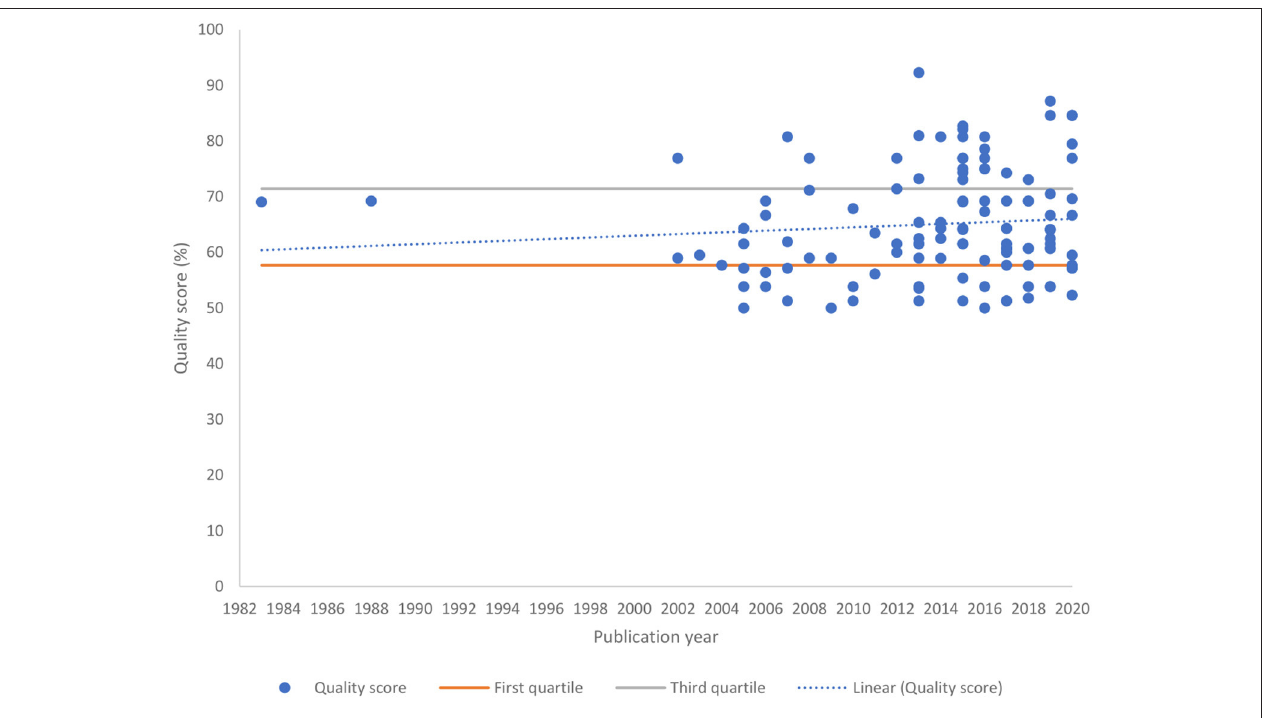
FIGURE 4 | Quality scores of included studies against the guidelines for studies involving data